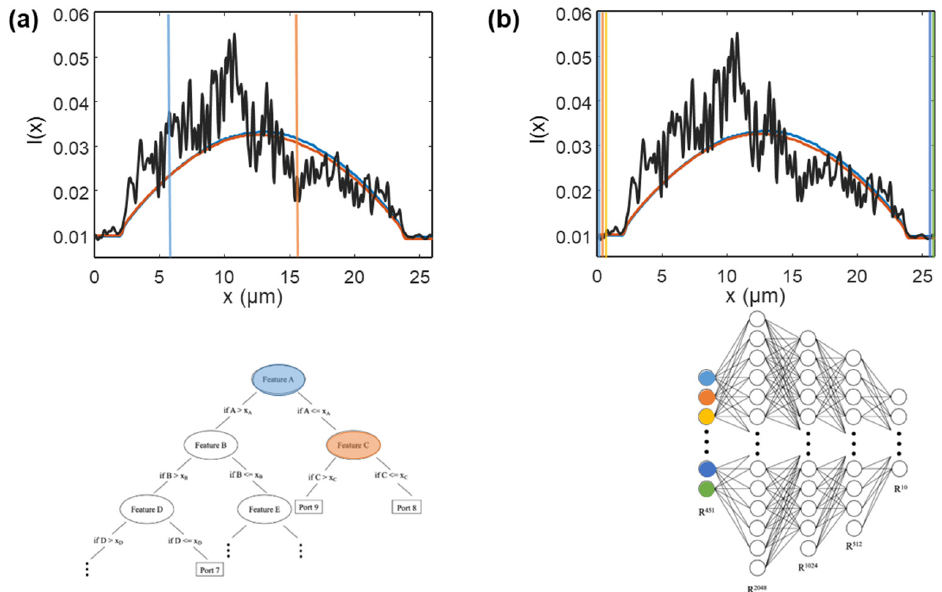
Figure 3. Diagrams explaining how the decision trees and neural networks were used for the classification task – the vertical-colored lines indicate the different intensity distribution values at different spatial points used for classification: ( a ) Diagram theoretically showing how the trained decision tree classifier can be used to classify an intensity distribution. Through training, the classifier creates the shown branching structure and learns which values of the distribution and which threshold value lead to the correct port number classification at the leaves of the tree; ( b ) Diagram theoretically showing how the trained neural network can be used to classify an intensity distribution. In the 451-neuron input layer, one value of the intensity distribution is assigned to one neuron in the order dictated by the distribution. Learned weights between the layers result in a 10-neuron one-hot vector with one port being marked as the predicted port.